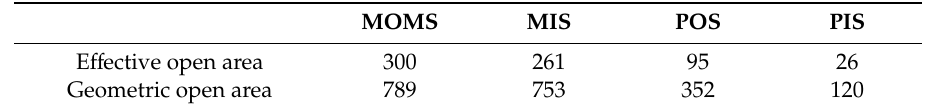
Table 1. Swirler e ff ective and geometric open areas (mm 2 ). (Copyright by ASME—“E ff ects of Fluidic Control of Air-Flow Distribution on Staged Lean Jet Engine Burner,” by Yoshida, Schneider, Hassa, Table 1. Swirler effective and geometric open areas (mm 2 ). (Copyright by ASME — "Effects of Fluidic Paper No: GT2016-57453). Control of Air-Flow Distribution on Staged Lean Jet Engine Burner," by Yoshida, Schneider, Hassa, Paper No: GT2016-57453).